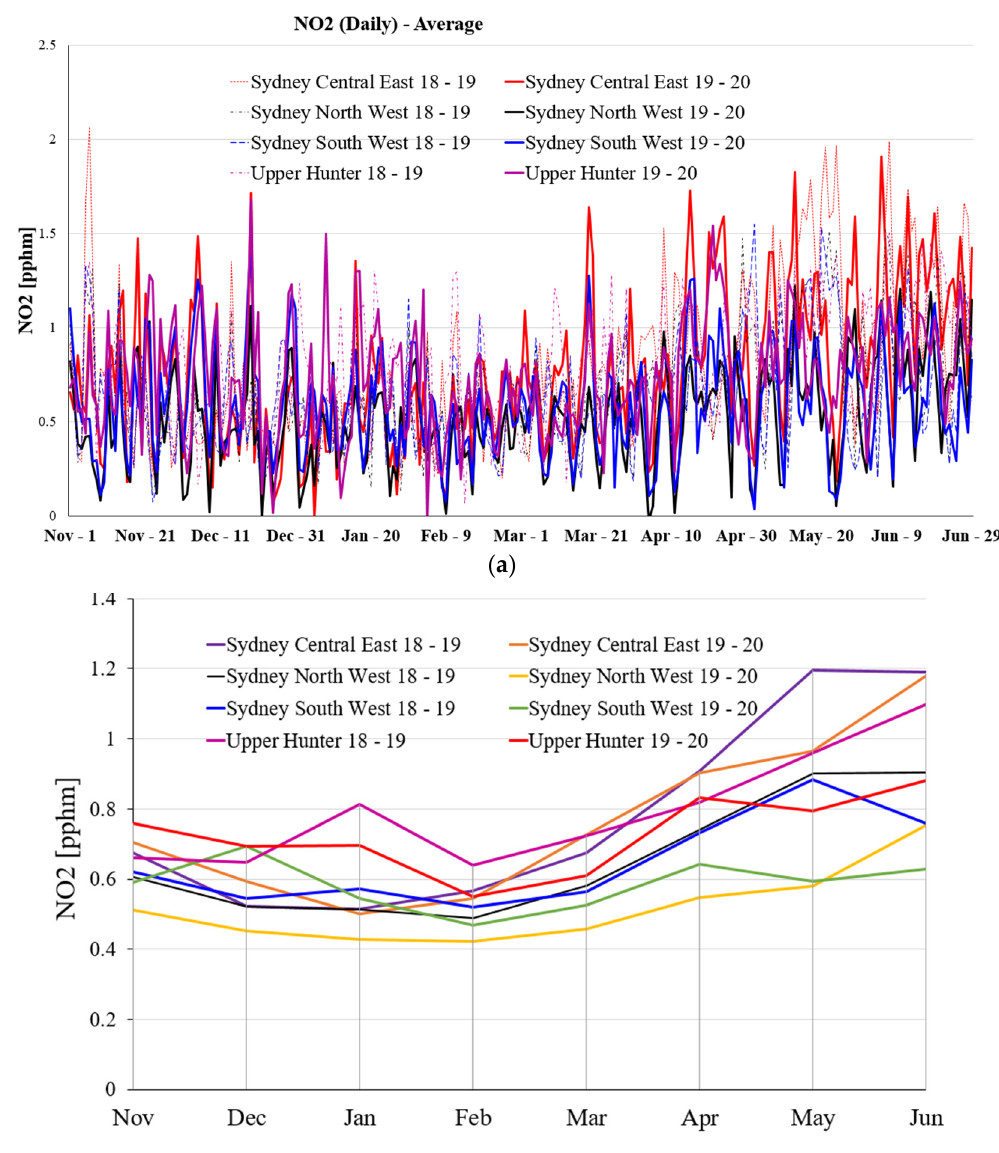
Figure 7. The average NO 2 emission in Sydney Central East, North West, South West, and Upper Hunter region for a period of eight months during 2018–2019 and 2019–2020, ( a ) daily average NO 2 emission, and ( b ) monthly average NO 2 emission.